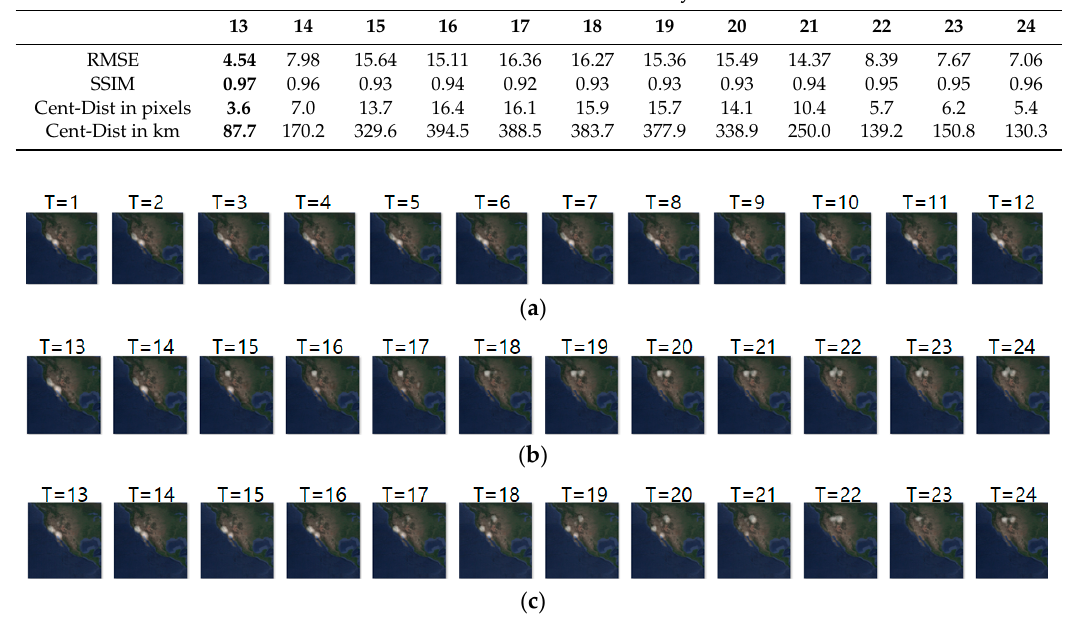
Figure 13. Movement prediction result–( a ) input sequence; ( b ) ground truth; ( c ) predicted sequence.